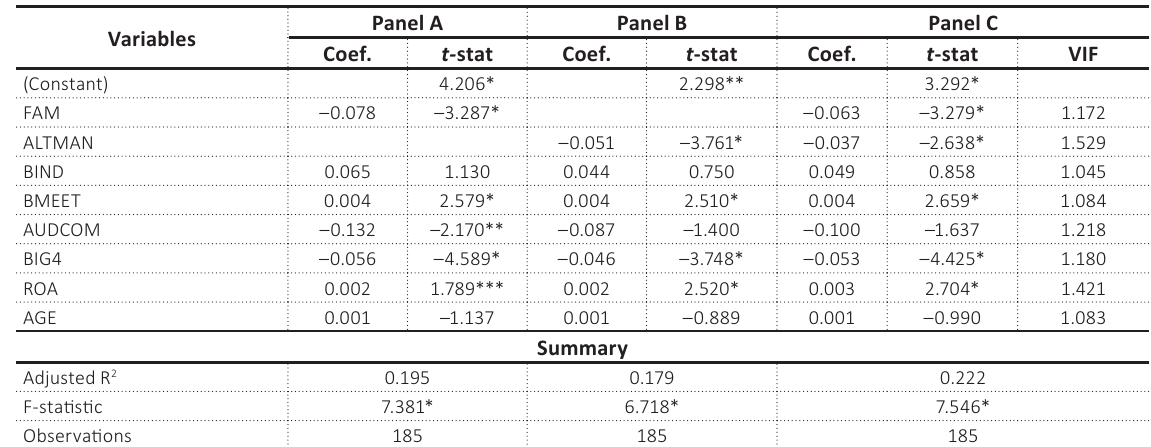
Table 4. Regression results